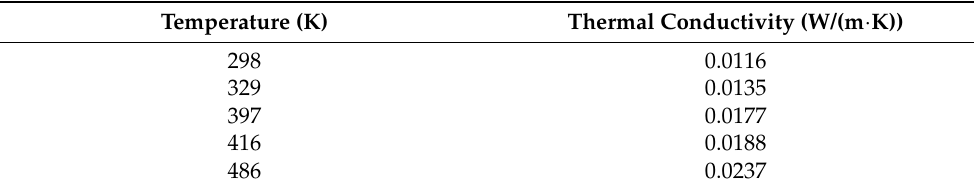
Table 4. The relationship between temperature and thermal conductivity of biodiesel. Temperature